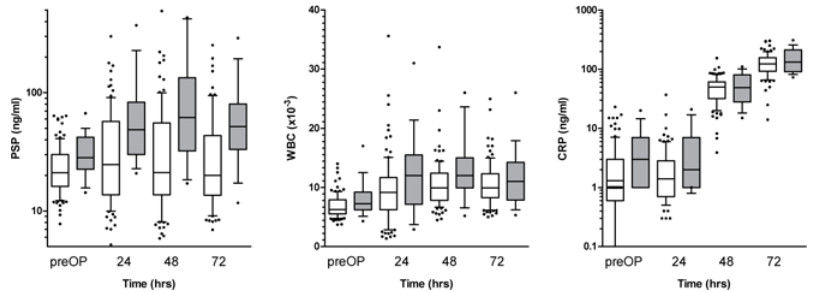
Fig 3. Discriminatory power of biomarkers for postoperative infection. PSP levels showed a significantly stronger postoperative rise at day 1 – 3 in patients receiving a diagnosis of infection during their hospital stay as opposed to patients exhibiting an uneventful course. (p < 0.05 for interaction, determined by a linear mixed effects regression model). Other biomarkers (CRP and WBC) failed to differentiate infection from postoperative inflammatory power.